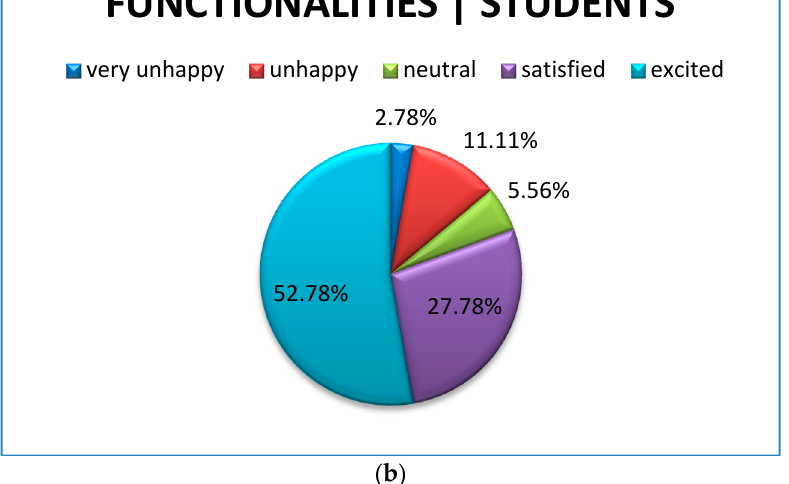
Figure 18. ( a ) Platform functionalities evaluation results by school staff; ( b ) Platform functionalities evaluation results by student.